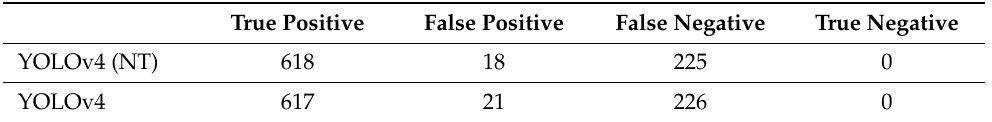
Figure 13. Two examples of detection results for YOLOv4 model with negative training using yellow sticky tape image from web-RAID monitor. Table 3. YOLOv4 Confusion